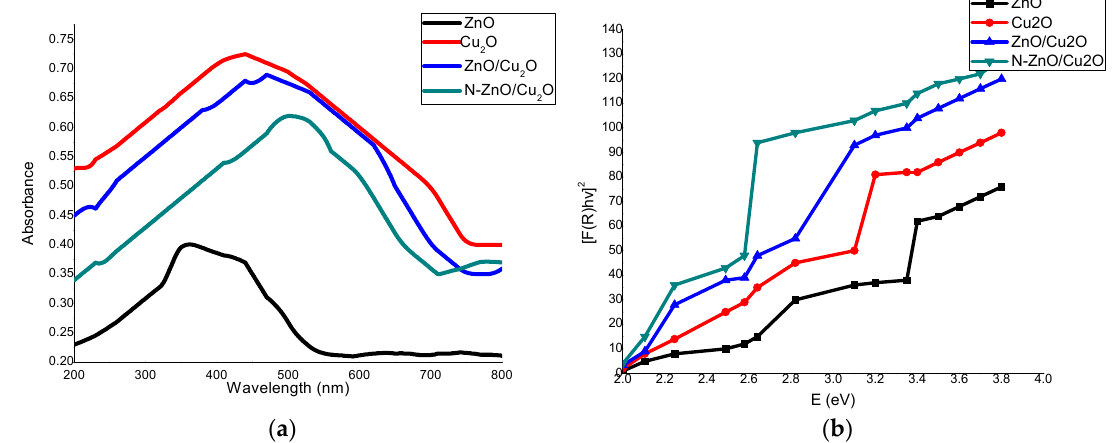
Figure 4. ( a ) Spectra for the optical property of ZnO, Cu 2 O, Cu 2 O/ZnO and N-Cu 2 O/ZnO nanomaterials. ( b ) Kubelka–Munk function versus energy plots of ZnO, Cu 2 O, ZnO/Cu 2 O, and N-ZnO/Cu 2 O nanoparticles.